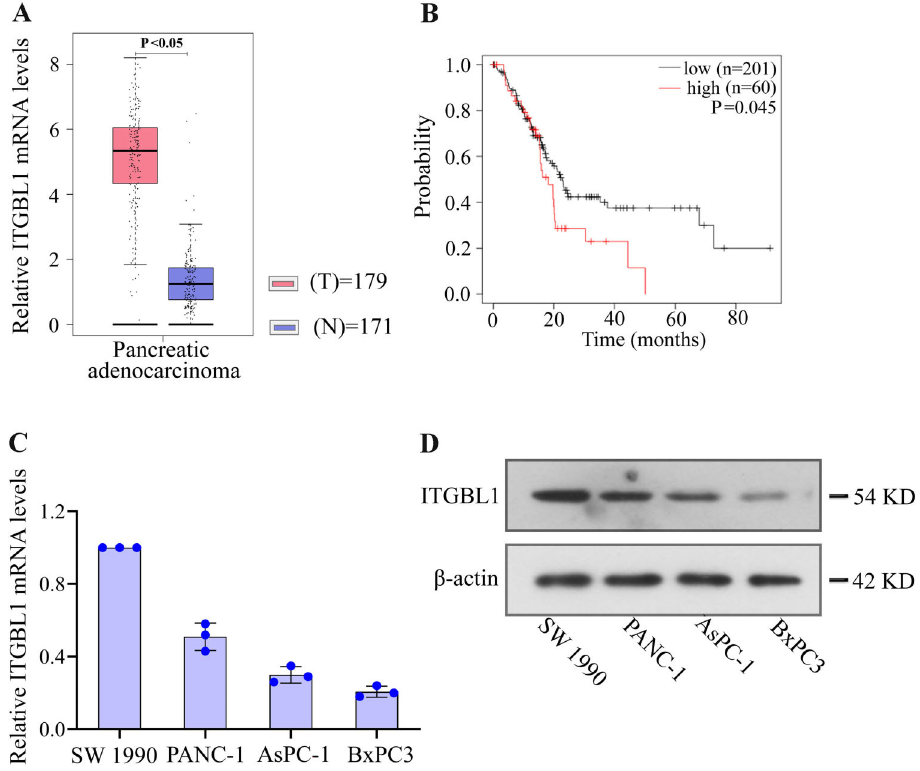
Figure 1. ITGBL1 is highly expressed in pancreatic cancer tissues. A , ITGBL1 mRNA expression in pancreatic adenocarcinoma tissues and normal tissues was analyzed by the GEPIA website based on the TCGA database. B, The overall survival time of PC patients with ITGBL1 high expression or low expression was analyzed by the Kaplan-Meier plotter database. C , Relative ITGBL1 mRNA expression in pancreatic cancer cell lines (SW 1990, PANC-1, AsPC-1, and BxPC3) was detected by real-time quantitative PCR. D , Relative ITGBL1 protein expression, standardized by b -actin, in pancreatic cancer cell lines (SW 1990, PANC-1, AsPC-1, and BxPC3) was detected by western blot. Data are reported as means ± SD for N=3